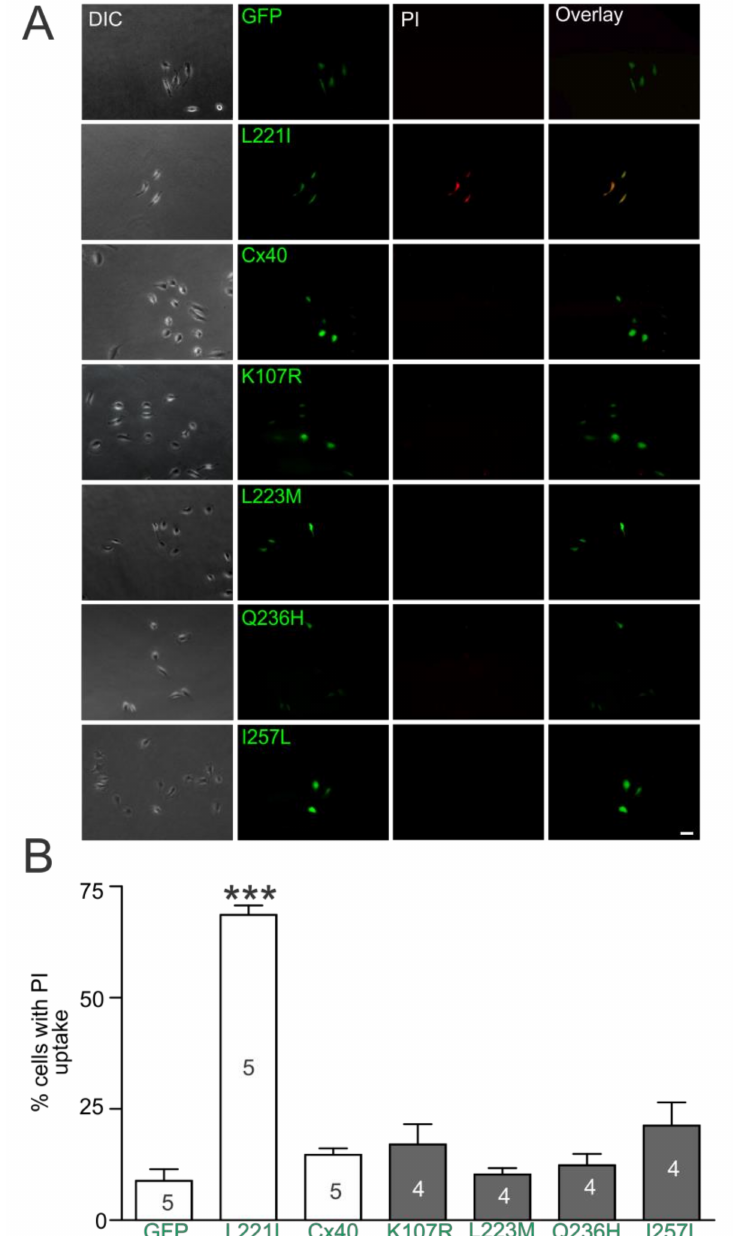
Figure 7. Propidium iodide uptake of AF-linked Cx40 mutants. ( A ) HeLa cells transfected with Cx40 mutants, empty vector GFP, or Cx40 are shown: column 1 (under DIC), column 2 (GFP fluorescence to show successful expression of respective vector), column 3 (propidium iodide [PI] uptake in red), column 4 (an overlay of images of column2 and 3). Only cells expressing L221I showed PI uptake. The scale bar = 50 µ m; ( B ) bar graph summarizes PI uptake percentage of isolated individual cells expressing Cx40 mutants, Cx40, or GFP. PI uptake percentage for each of the AF-linked mutants was not statistically different from that of wildtype Cx40 or the empty vector (GFP), except L221I (*** p < 0.001). The number transfection is indicated with observations of over 60 isolated cells for each